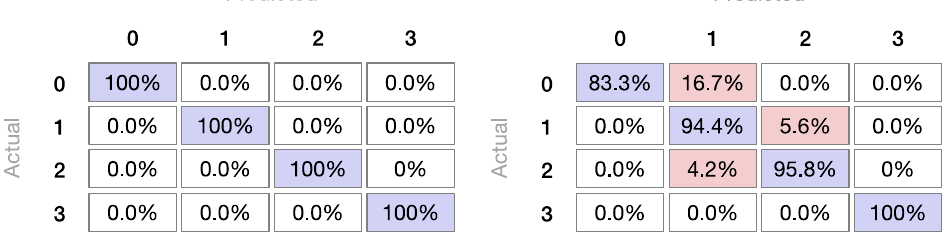
Figure 5. Confusion matrix (showing proportion of actual) for the decision tree model ( left ) and confusion matrix for the kNN model ( right ), both processing only three features. 0—Norway farmed,